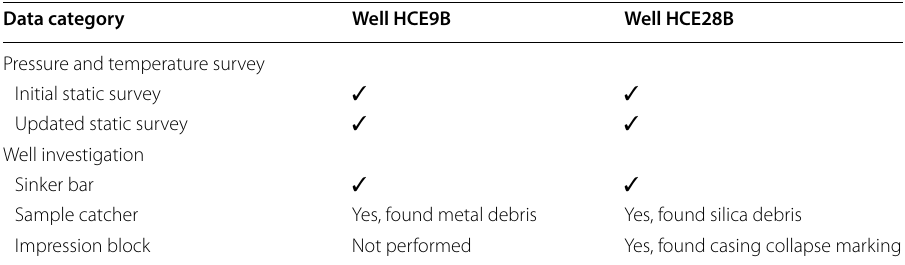
Table 1 Pressure and temperature survey and well investigation data (Marbun 2013; PT Geo Dipa Energi